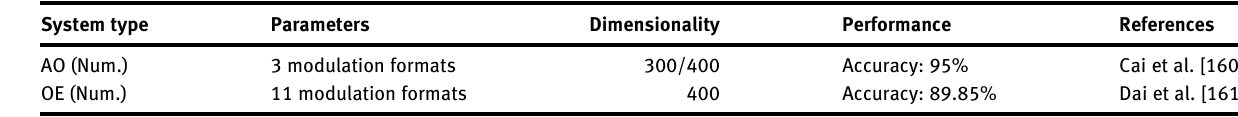
Table  : Photonic neuromorphic systems based on RC applied on the modulation format identi fi cation. System